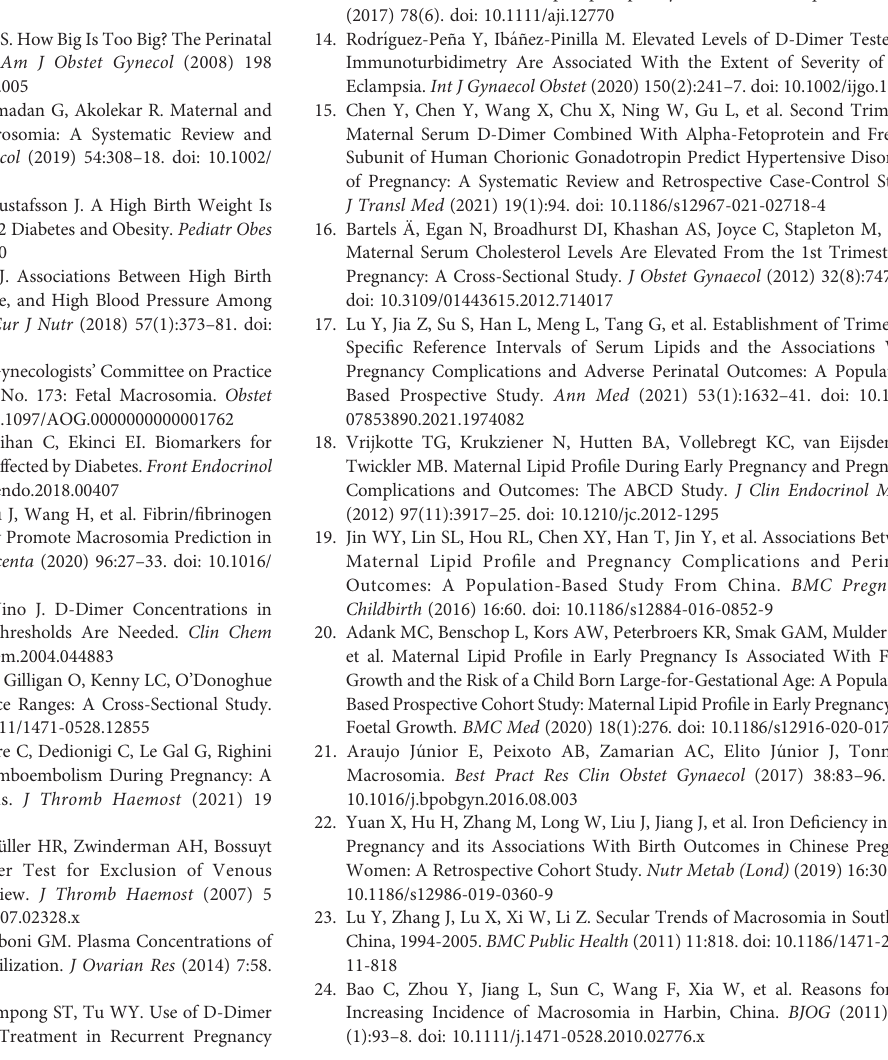
Supplementary Table 1 | Maternal and neonatal characteristics in the study populations according to birthweight. SGA/AGA/LGA, small/appropriate/large for gestational age; BMI, body mass index; BP, blood pressure; PTB, pre-term birth; GDM, gestational diabetes mellitus; LBW, low birthweight; NBW, normal birthweight; IQR, interquartile range. Data are presented as median (IQR), mean ± SD and